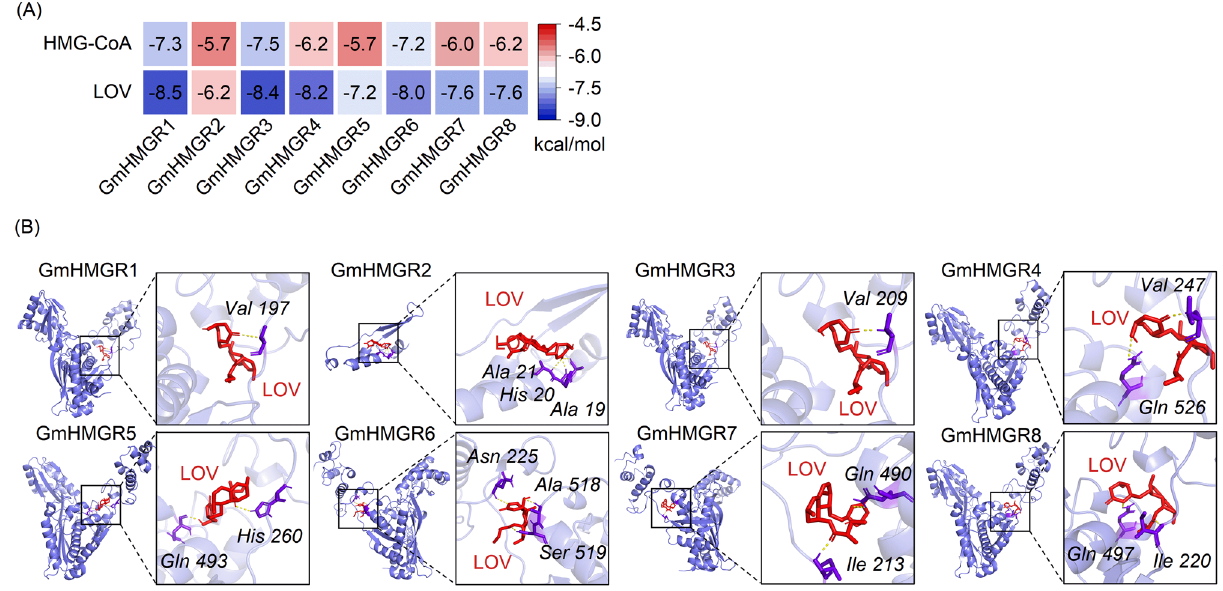
Figure 1. Docking analysis of GmHMGR proteins binding with LOV. ( A ) The docking binding energies of GmHMGR proteins with HMG-CoA and LOV. ( B ) Docking analysis visualization of GmHMGR binding with LOV. Amino acids that form hydrogen bonds are identified in purple while hydrogen bonds are shown in